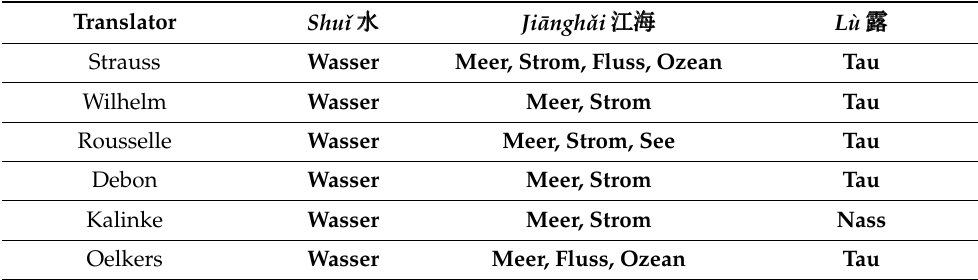
Table 3. Expressions of [Shuˇı] in the German Translations of the D à o D é J¯ıng